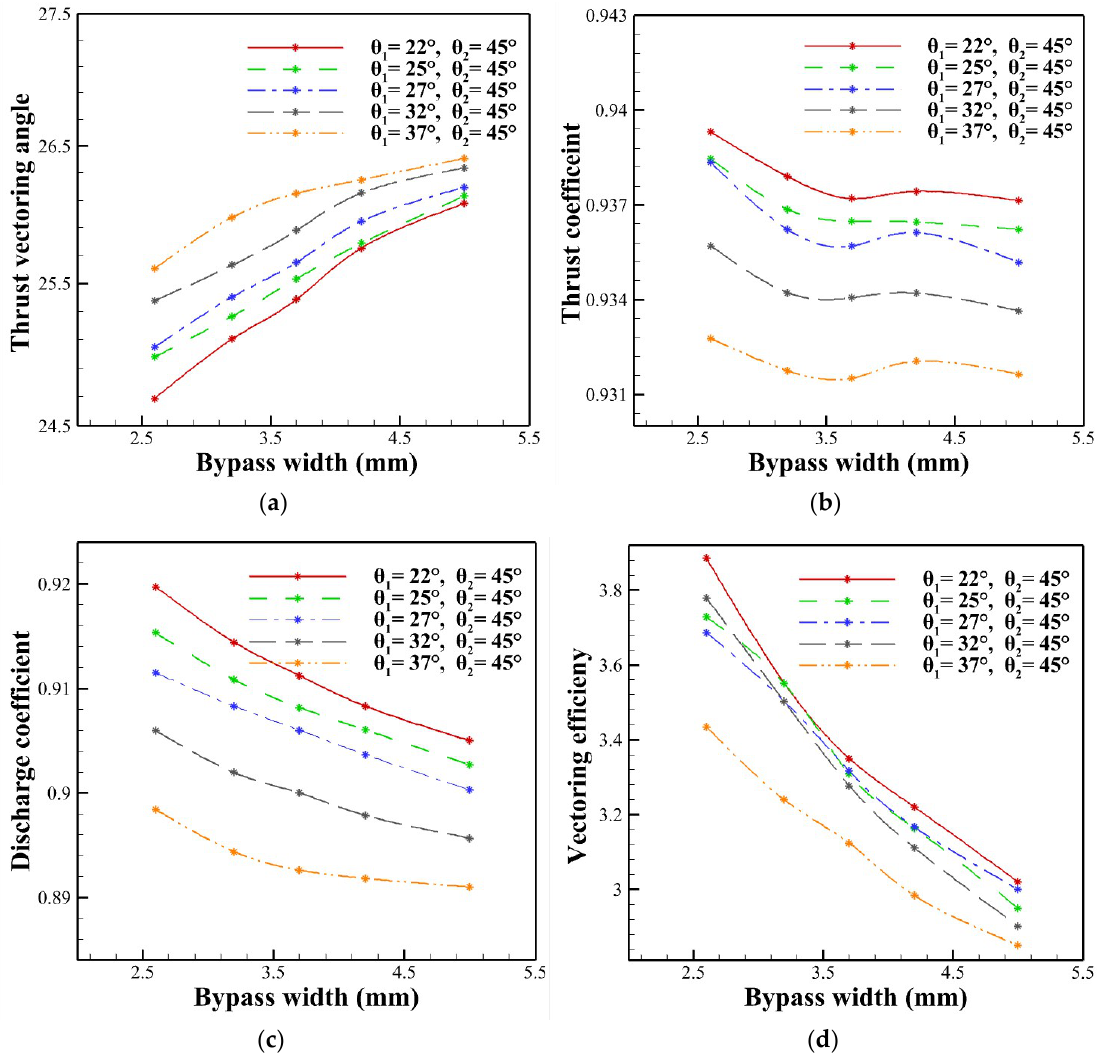
Figure 13. Variation of ( a ) the vectoring angle, ( b ) thrust coefficient, ( c ) discharge coefficient, and ( d ) vectoring efficiency with increasing bypass width at NPR = 3.